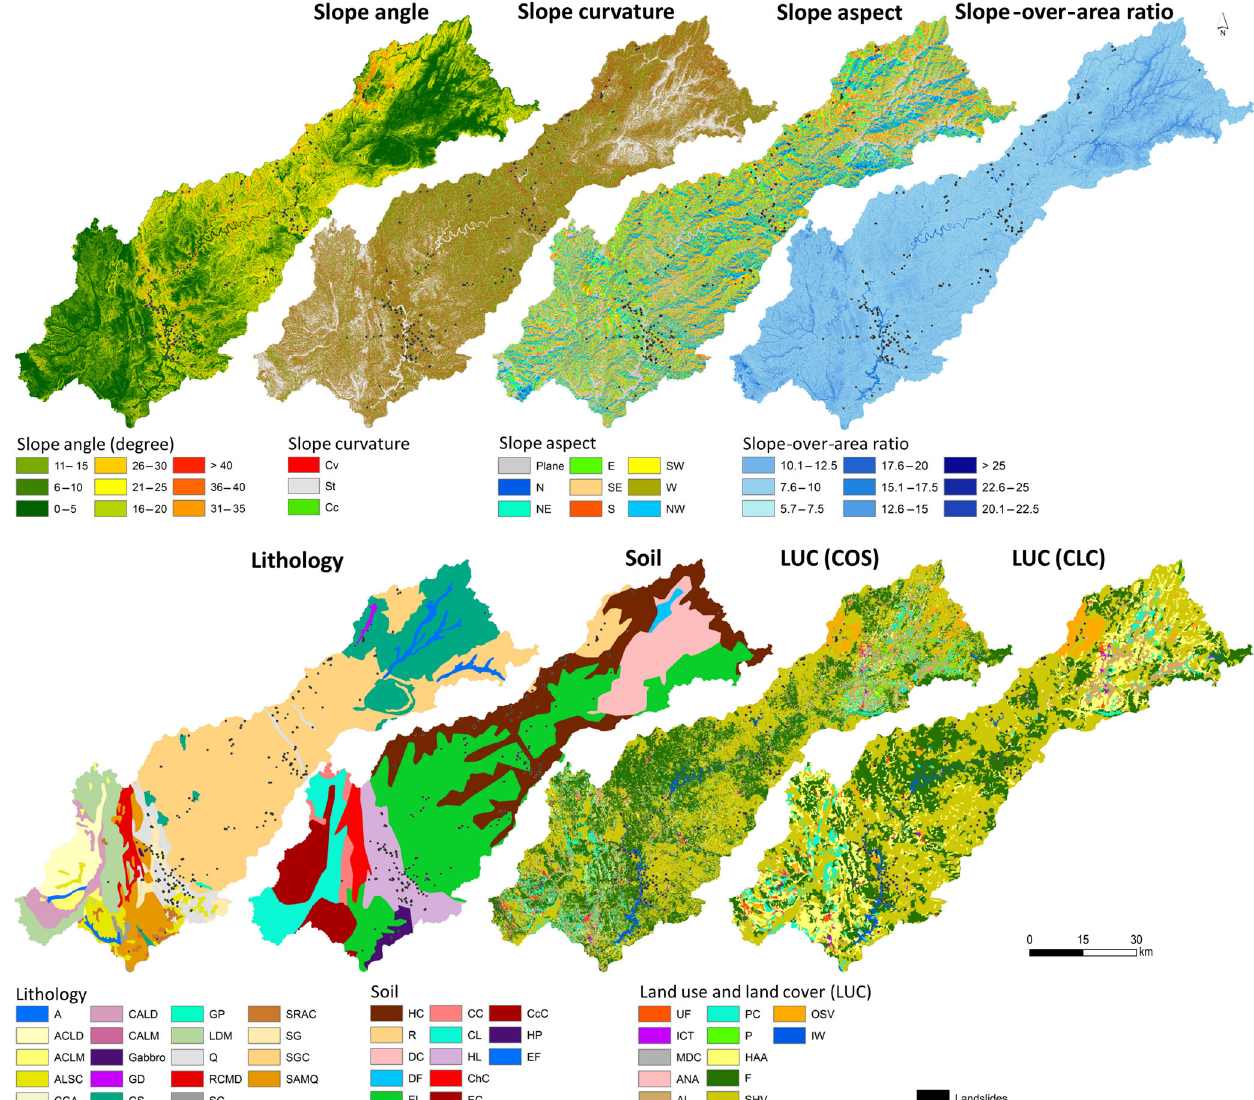
Figure 2. Predisposing factors used in the landslide susceptibility assessment. Predisposing factor map legend. Curvature – Cv: convex; St: straight; Cc: concave. Lithology – A: alluvium; ACLD: arenites, conglomerates, limestones, dolomitic limestone; ACLM: arenites, conglom- erates, limestones, dolomitic limestone and marl; ALSC: arenites, limestone, sand, stony banks and clay; CGA: clayey schist, graywackes and arenites; CALD: conglomerates, arenites, limestone, dolomitic limestone, marly limestone and marl; CALM: conglomerates, arenites, white limestone and red marl; G: gabbro; GD: glacial deposits; GS: granite and other stones; GP: granite porphyritic; LDM: limestones, dolomitic limestone, marly limestone and marl; Q: quartzite; RCMD: red sandstone, conglomerates, marl and dolomitic limestones; SG: sands and gravel; SRAC: sands, rocky, arenites and clay; SG: schists and graywackes; SGC: schist and graywacke complex; SAMQ: schists, amphibolite, mica schists, quartzite graywackes, carboned stones and gneisses. Soil – HC: humic Cambisols; R: rankers; DC: dystric Cam- bisols; DF: dystric Fluvisols; EL: eutric Lithosol; CC: calcic Cambisols; CL: calcic Luvisols; HL: hortic Luvisols; ChC: chromic Cambisols; EC: eutric Cambisols; CcC: calcic–chromic Cambisols; HP: hortic Podzols; EF: eutric Fluvisols. LUC – UF: urban fabric; ICT: industrial, commercial and transport units; MDC: mine, dump and construction sites; ANA: artificial, nonagricultural vegetated areas; AL: arable land; PC: permanent crops; P: pastures; HAA: heterogeneous agricultural areas; F: forests; SHV: scrub and/or herbaceous vegetation associations; OSV: open spaces with little or no vegetation; IW: inland